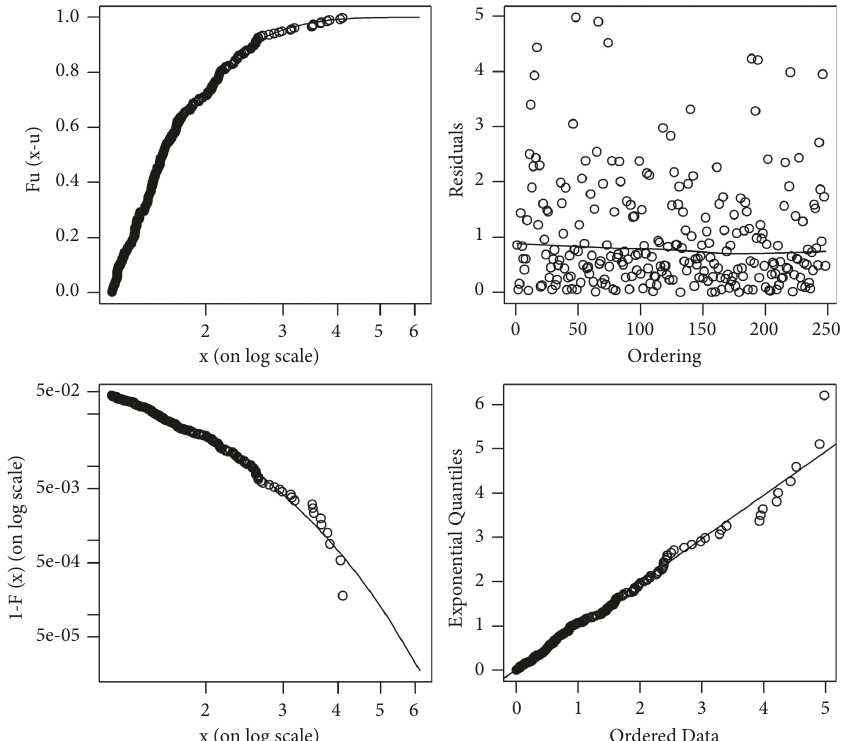
Figure 4: Soybean oil positive returns GPD fitted diagnostic